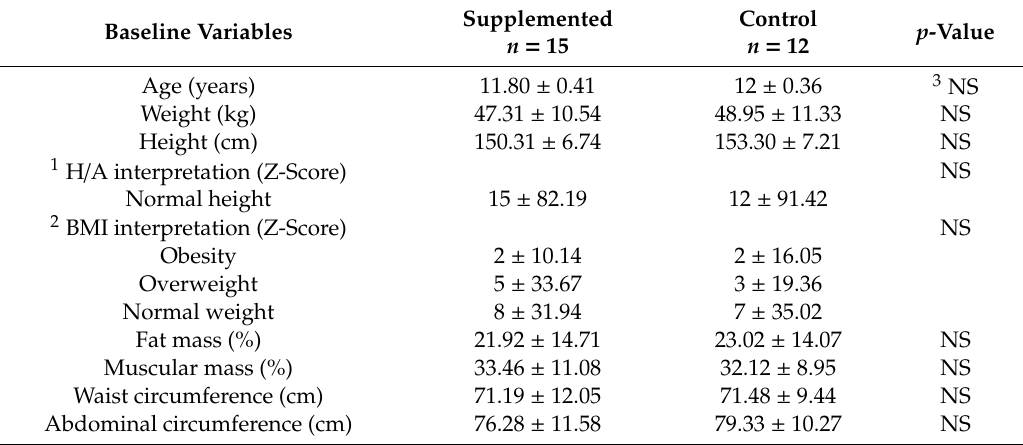
Table 1. General characteristics of participants of the supplemented and control